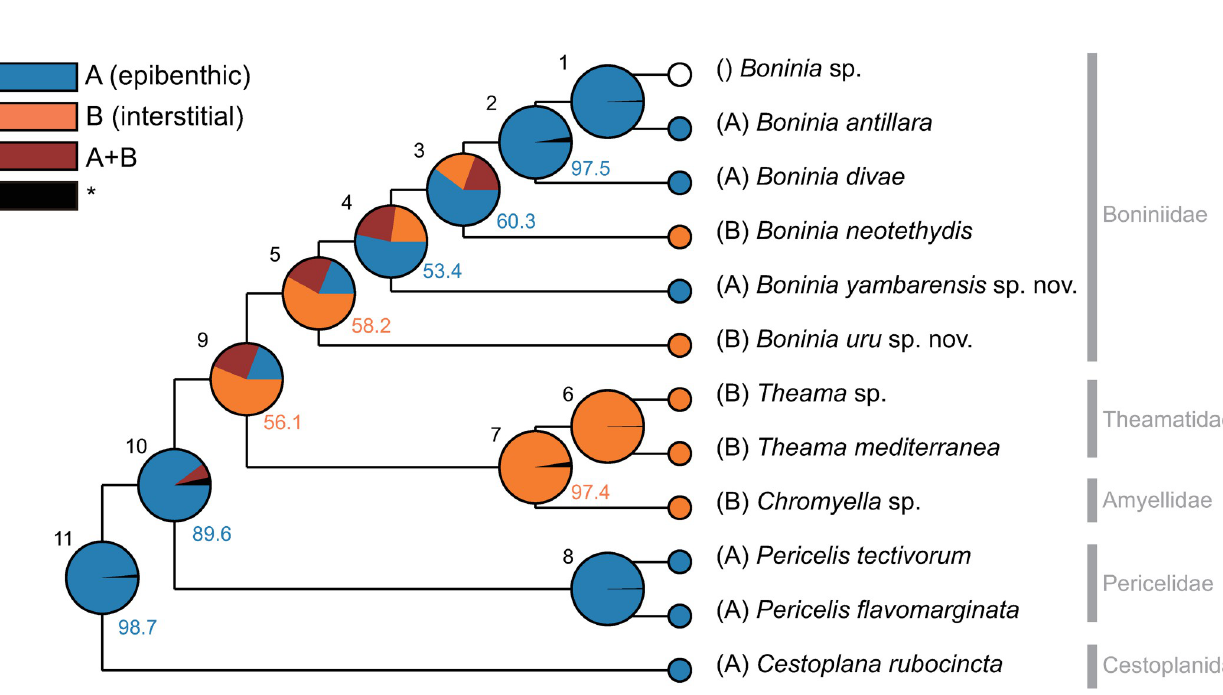
PLOS ONE | https://doi.org/10.1371/journal.pone.0276847 November23, 2022 17 /